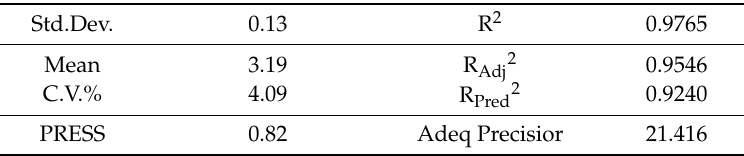
Table 8. Credibility analysis of modified regression